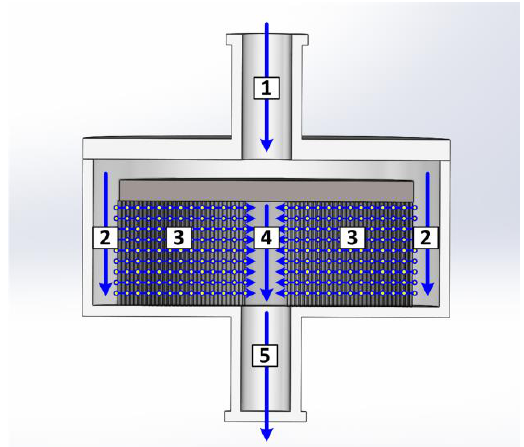
Figure 5. Overview of different fluid dynamic models. ( A ) Distributed plug flow model; ( B ) Roper– Lightfoot model [64]; ( C ) zonal rate model [59,60]. PFR, Plug Flow Reactor. In this work, a different approach was chosen. The module was subdivided into five areas as shown in Figure 6. These were the inlet (1) and outlet (5), the annular gap (2), the inner cylinder (4), and the membrane itself (3). Each zone was described by an individual mass balance.